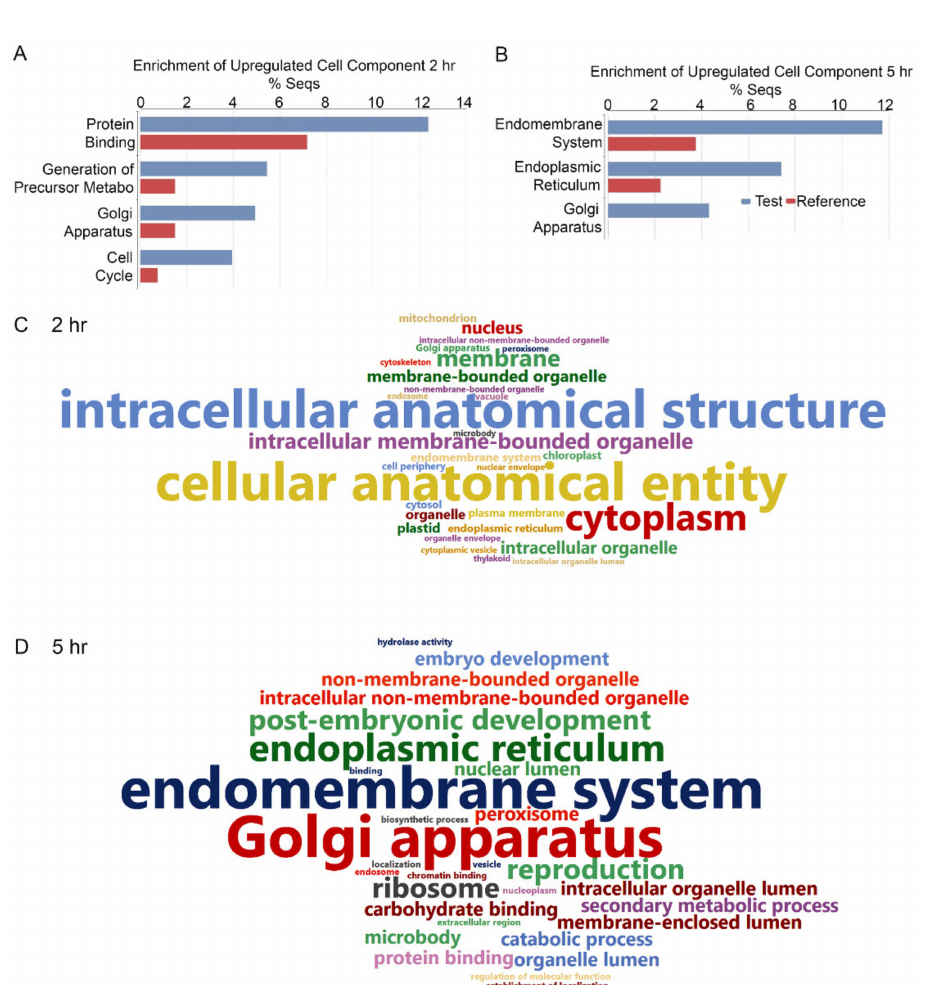
Figure 3. Functional enrichment of the cellular component of upregulated genes. Upregulated genes at ( A ) 2 and ( B ) 5 h; p < 0.05 using Fisher’s exact test. Word Clouds present detailed cellular components at ( C ) 2 and ( D ) 5 h after the TM